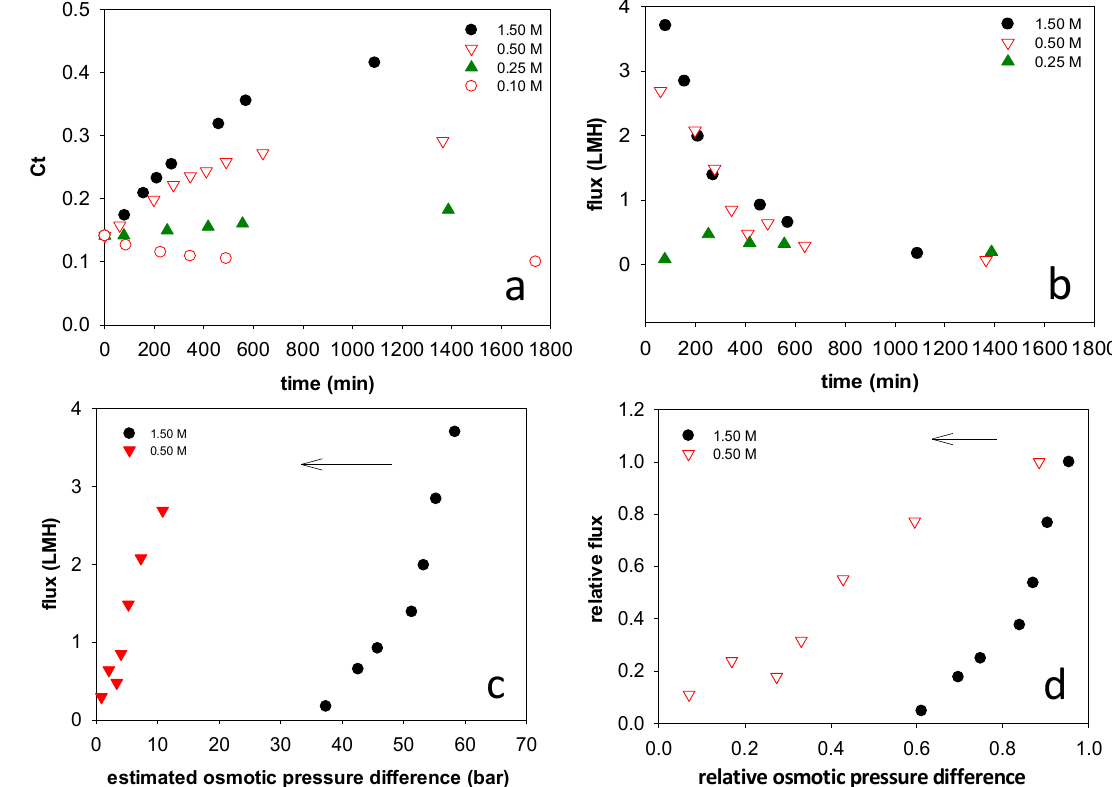
Figure 3. Impacts of draw solution concentration on stick water solid mass ratio and dewatering flux. Values in the legends indicate NaCl concentration in the draw solution. ( a ) Stick water mass fraction change with time using different draw solution concentrations; ( b ) Water removal flux change over time using different draw solution concentrations; ( c ) Water removal flux change versus estimated osmotic pressure difference across the membrane using different draw solution concentrations. (The arrow indicates the direction of change during dewatering); ( d ) Relative water removal flux versus relative osmotic pressure difference across the membrane using different draw solution concentrations. (The arrow indicates the direction of change during dewatering.).